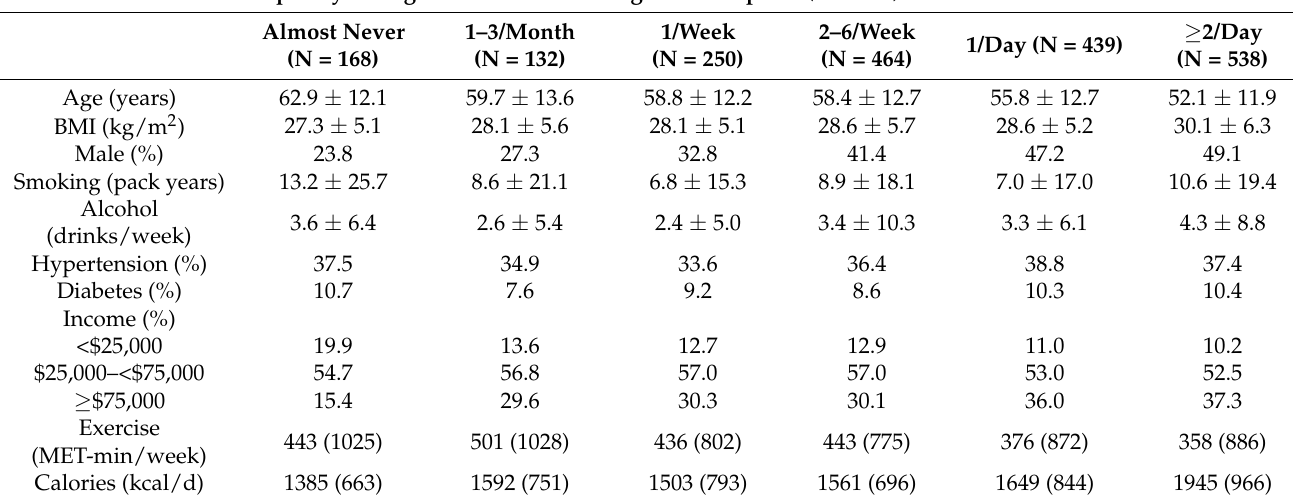
Table 1. Characteristics among 1991 participants of the NHLBI Family Heart Study according to sugar-sweetened bever- age